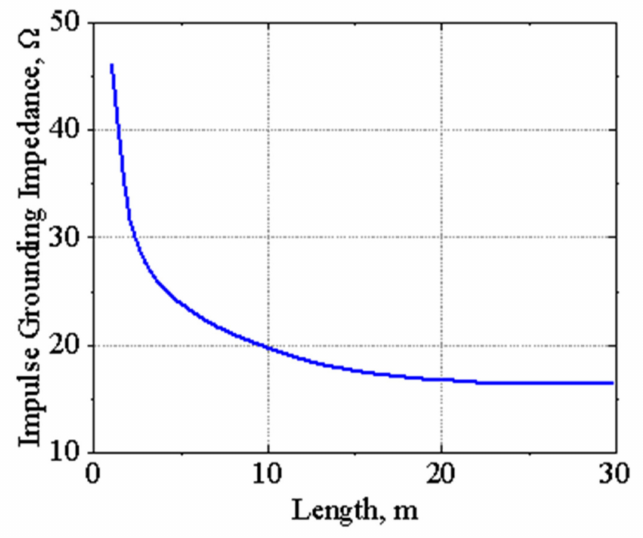
Figure 5. Influence of length on the impulse grounding impedance of a vertical rod with soil resistivity of 500 Ω m, critical electric field of 10 kV/cm, current peak of 50 kA and waveform 0.25/100 µ s.